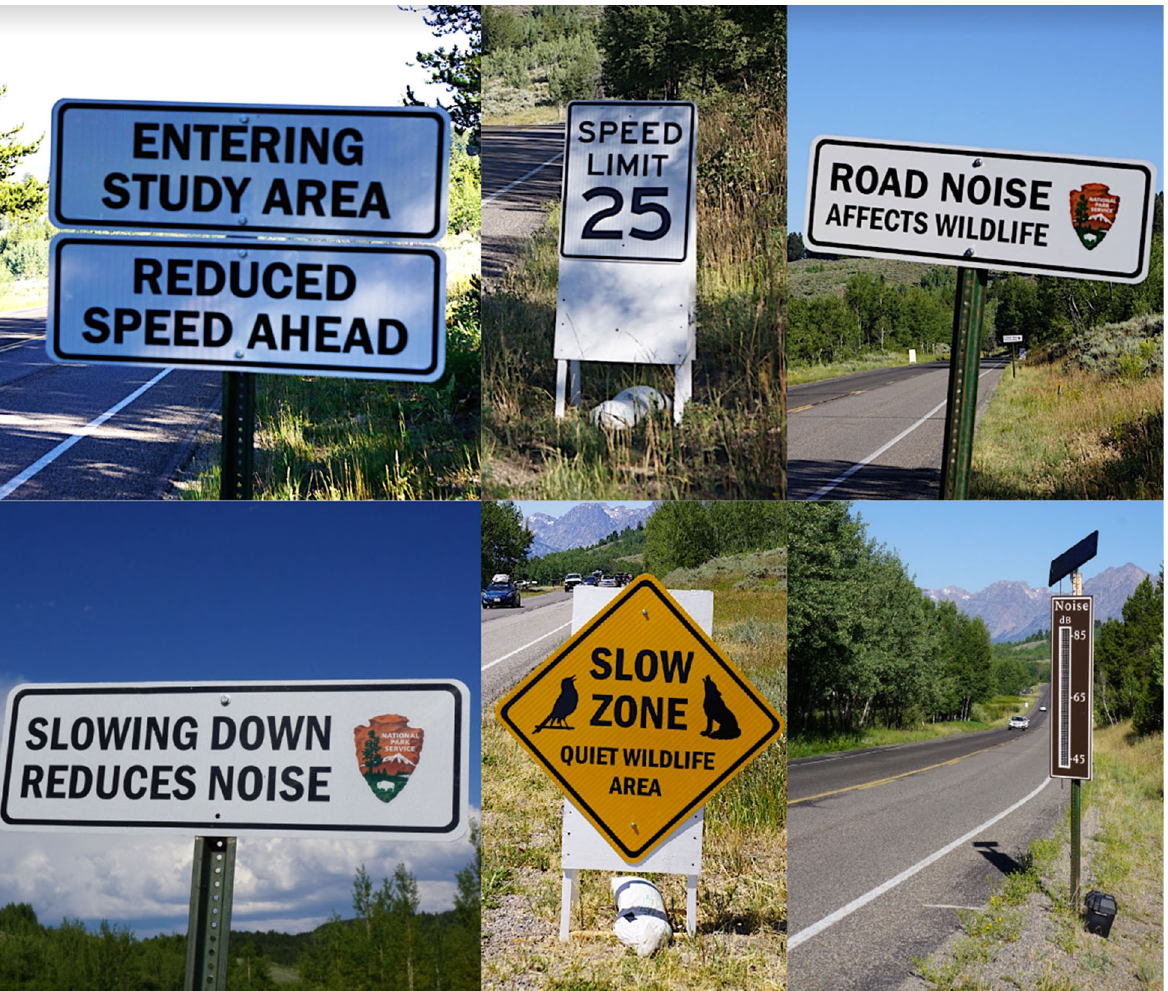
Fig. S1. Enforcement and educational signage used within the experimental road corridor during treatment blocks. Table S1. Speed limit counts classified by traffic